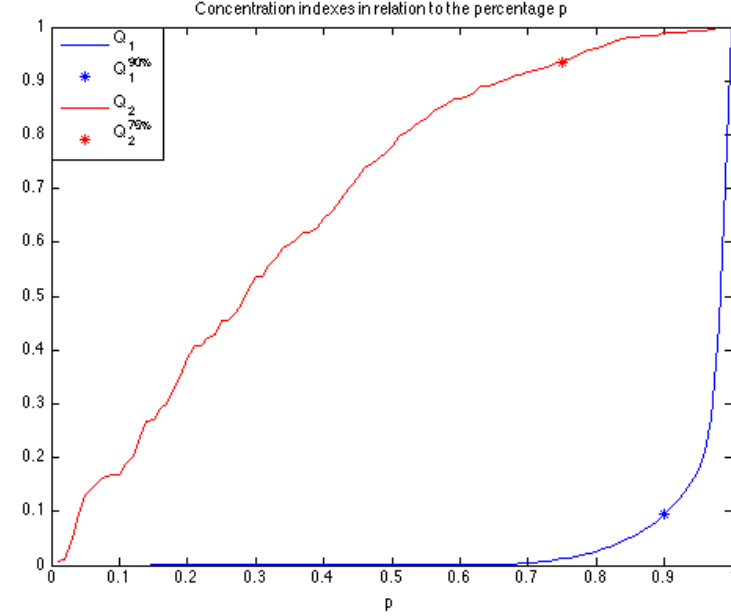
Figure 6: Plot of the concentration indexes of a simulated